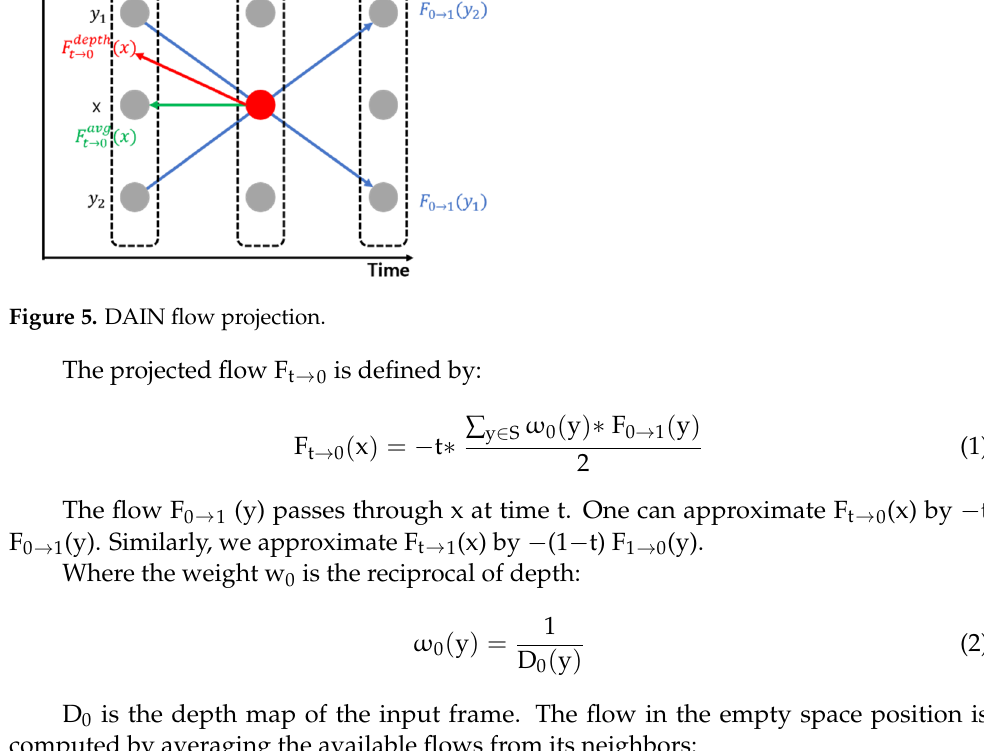
Figure 5. DAIN flow projection.